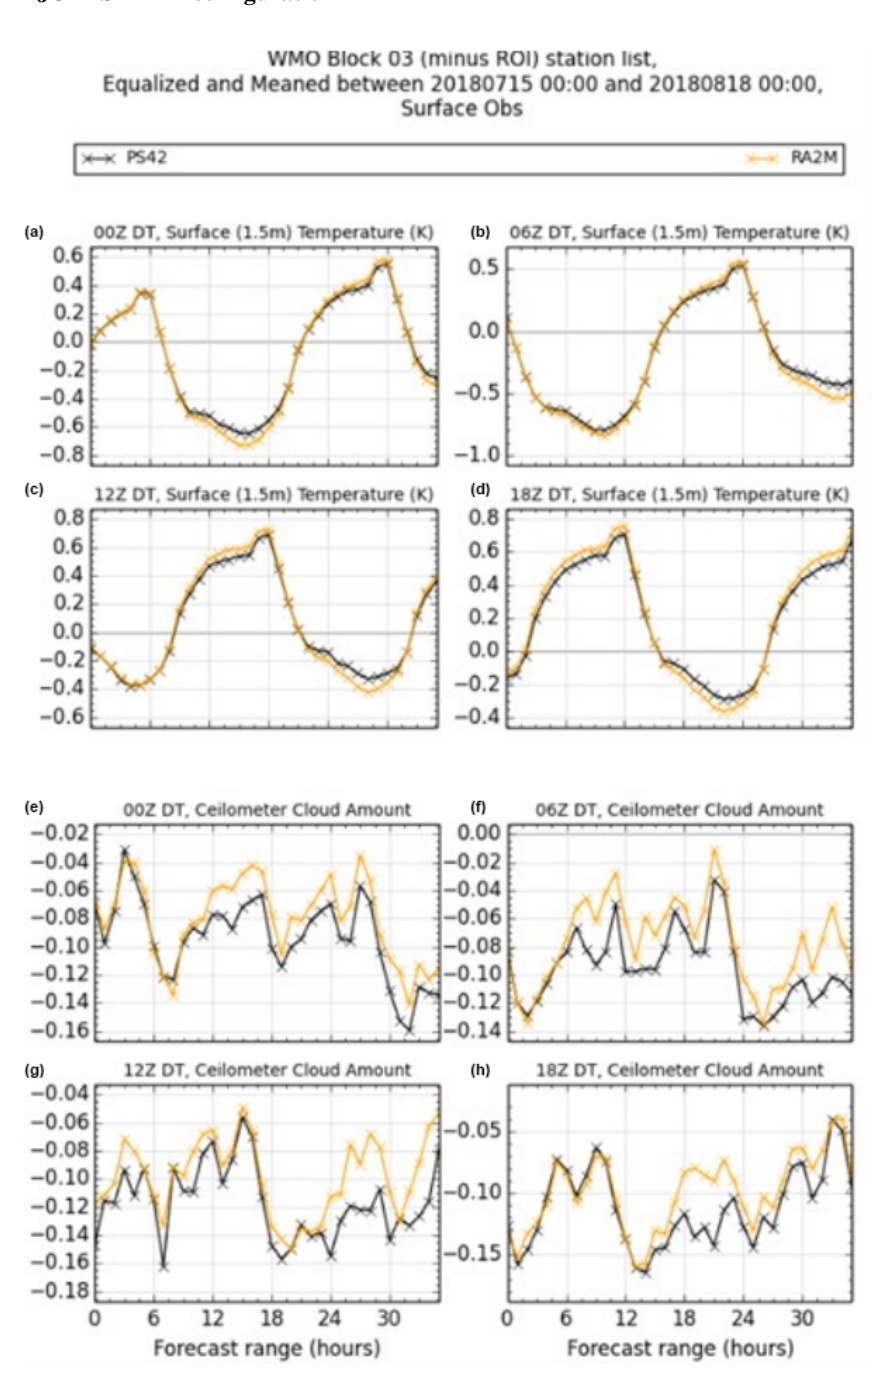
Figure 10. The 4D-Var trials: diurnal cycle of screen temperature bias (a–d) and cloud bias (against ceilometer cloud obs) (e–h) in summer for RAL1 (black) and RAL2